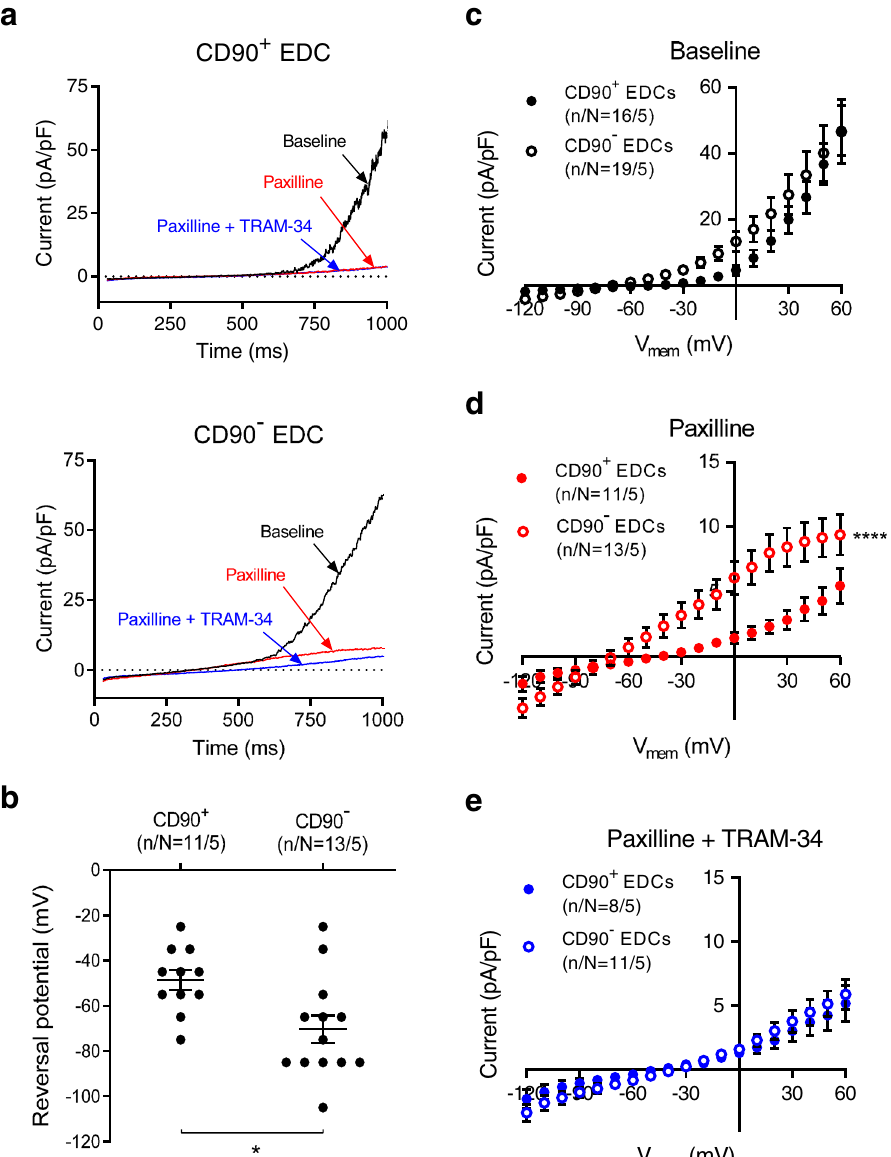
Fig. 1 Endogenous ion currents expressed in human EDCs. a Original whole-cell currents from CD90 + (upper panel) and CD90 − EDCs (lower panel) under various experimental conditions, with a 1000-ms depolarizing voltage-ramp protocol from − 120 to + 60 mV, with a holding potential of − 40 mV, before and after the addition of KCa inhibitors. Baseline = black, paxilline = red, paxilline + TRAM-34 = blue. b Reversal potential of whole-cell ion currents recorded in CD90 + and CD90 − EDCs in the presence of 300 nmol/L free-[Ca 2 + ] i . c – e I – V relationship of whole-cell ion currents (recorded with 1000 ms voltage-ramps from − 120 to + 60 mV with a holding potential of − 40 mV) in CD90 + and CD90 − EDCs under c basal conditions, d after addition of 1 µ mol/L paxilline, or e after addition of 1 µ mol/L paxilline and 1 µ mol/L TRAM-34. Open circles = CD90 − , closed circles = CD90 + . Two-sided non-paired student t -test (panel b ); two-way repeated-measures ANOVA showing signi fi cance of group effect; n/N = cells/cell lines per group. EDC explant-derived cell. Data in b – e are shown as individual data points along with mean and SEM. * P < 0.05; **** P < 0.0001 vs CD90 − EDCs. For precise P values, see Supplemental Source Data and Statistics fi